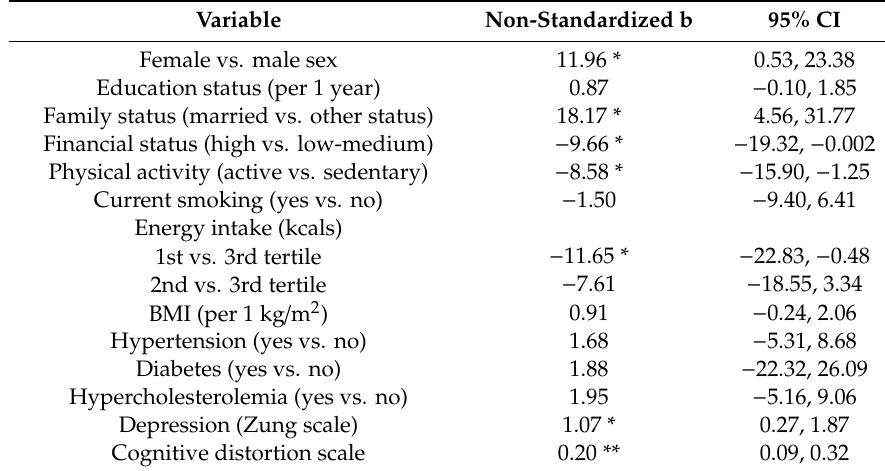
Table 3. Correlates of anxiety among adults aged ≥ 50 years estimated by multivariable linear regression, in the ATTICA study, n = 758.